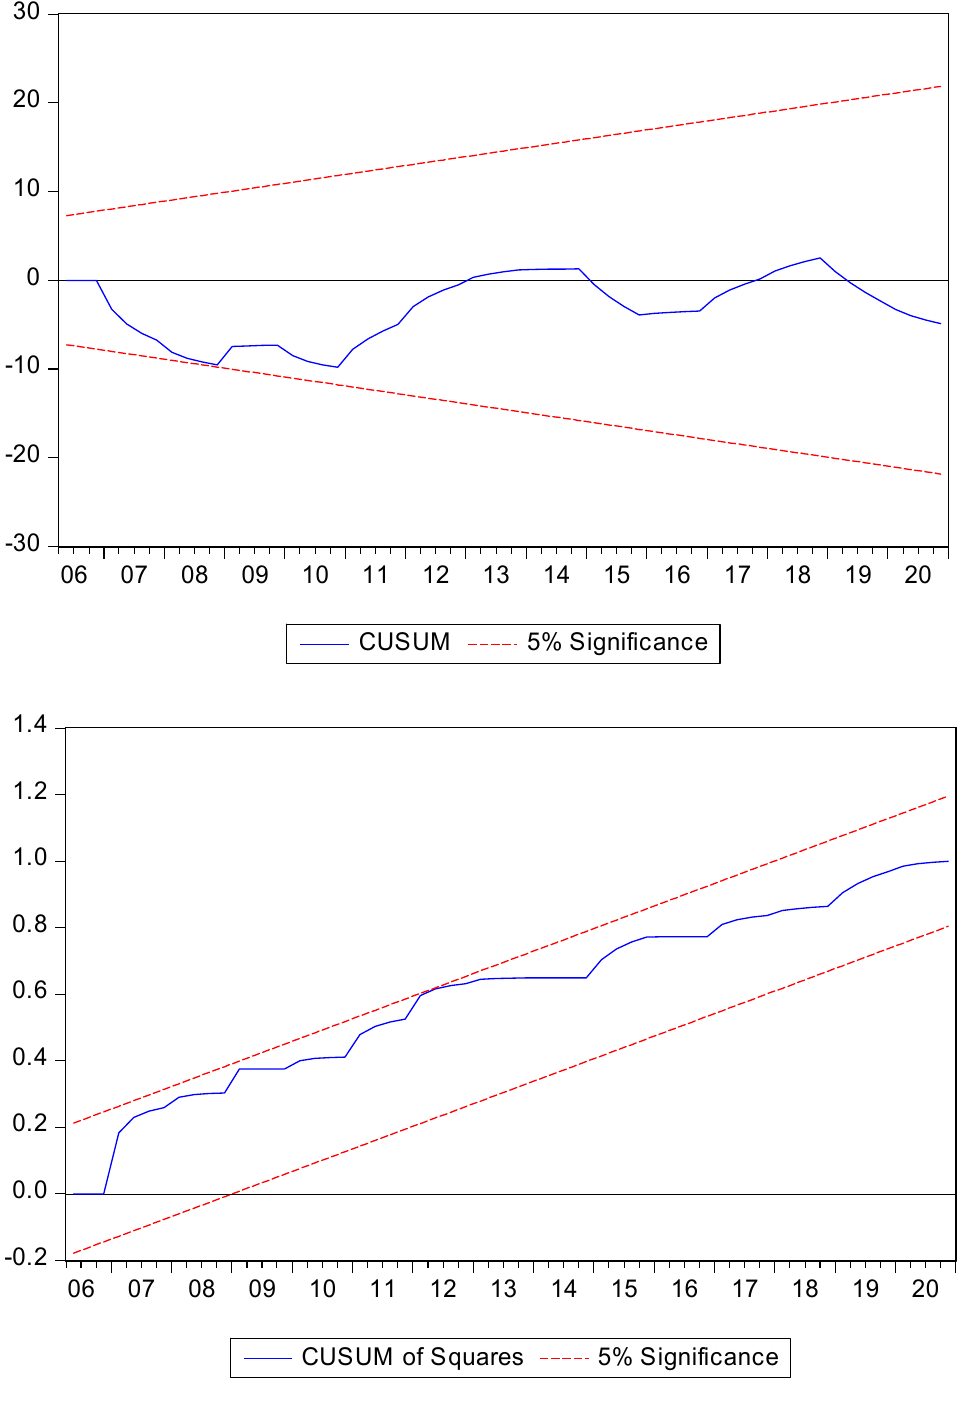
Figure 3. CUSUM and CUSUM Square Estimates. Source: Author’s estimates.